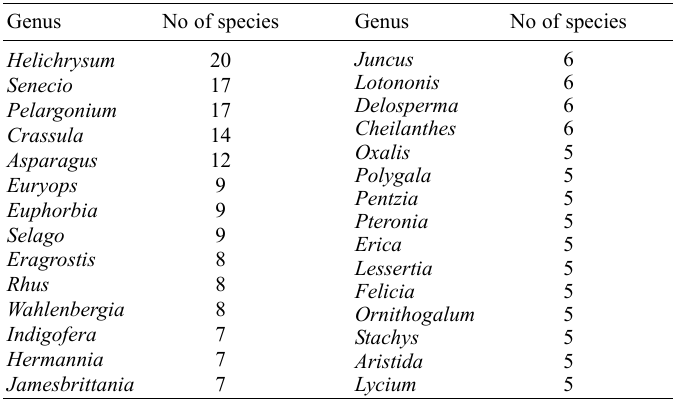
ilies represent 52.3 % of the MZNP flora, while the other 79 families reflect the remaining 47.7 %. Twenty-nine genera are represented by five or more species. These are listed in Table 2. Thirteen Red Data species were found, rep- resenting 1.9 % of the MZNP flora (Fig. 4). Red Data species and the categorisation are indicated in the species list (Appendix 1). Symbols and terms used in Appendix 1: